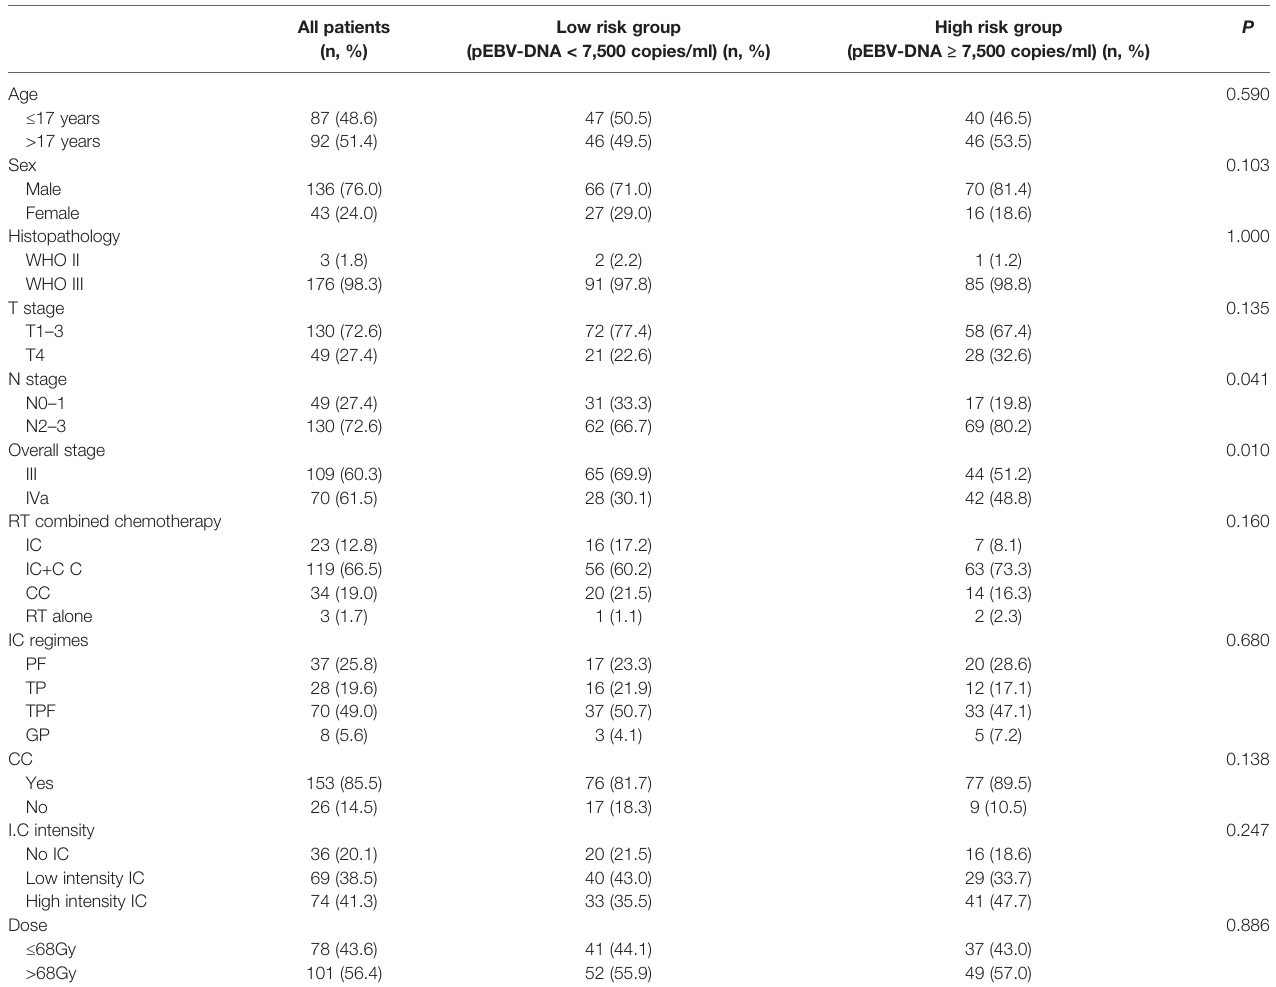
TABLE 1 | Baseline characteristics of the patients.